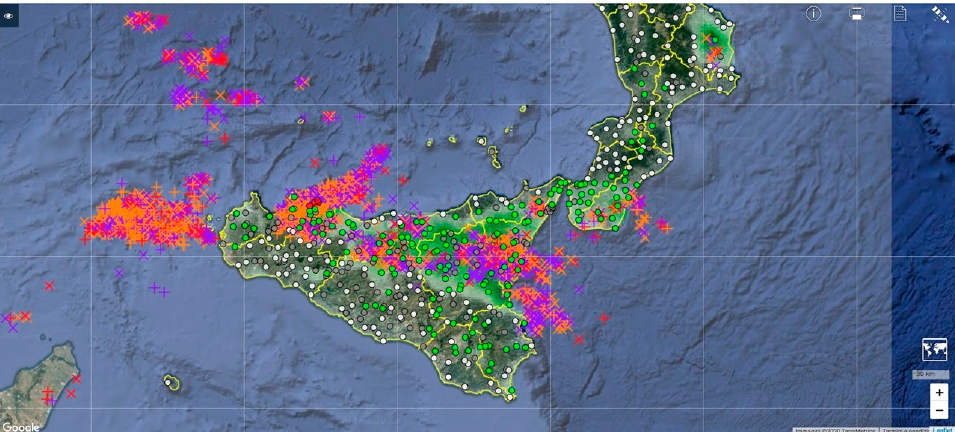
Figure 4. Lightning strikes detected by the Italian Air Force Meteorological Service (LAMPINET) during the 15 of July from 13 to 16 UTC. Image obtained from myDEWETRA platform, courtesy of the Italian Civil Protection Department.